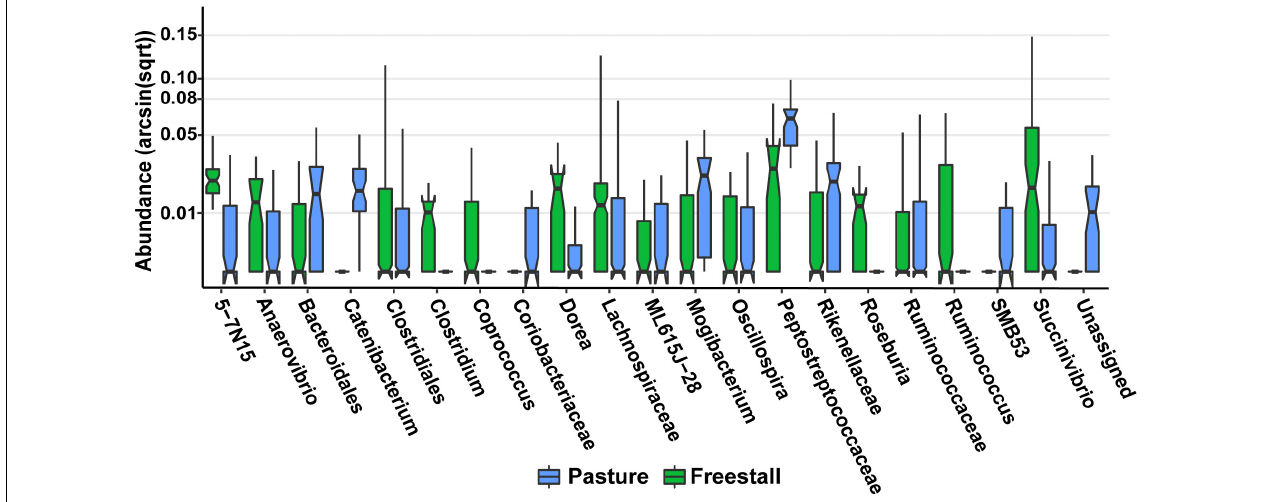
FIGURE 7 | Specific OTUs significantly associated with pasture based farms ( q > 0.01), as determined by MaAsLin using a subset of six farms from the original dataset that had complete metadata records, are displayed. OTUs were collapsed and combined by their lowest assigned taxonomy and plotted by transformed [arcsin(sqrt)] abundance. Notched box plots show individual arcsine square-root transformed relative abundance’s median as well as the first and third quartiles with notches representing a 95% confidence interval of the median. Pasture farms had significantly higher amounts of Coriobacteriaceae even when dietary components, age and stage of lactation were controlled